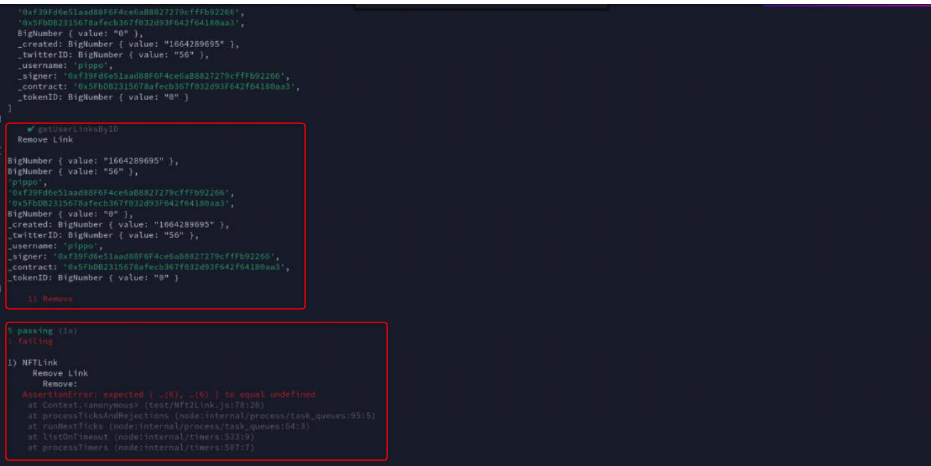
Figure 13. TwitterLink contract testing: getUserLinksByID and Remove. Table 1. Digital identity: smart contract